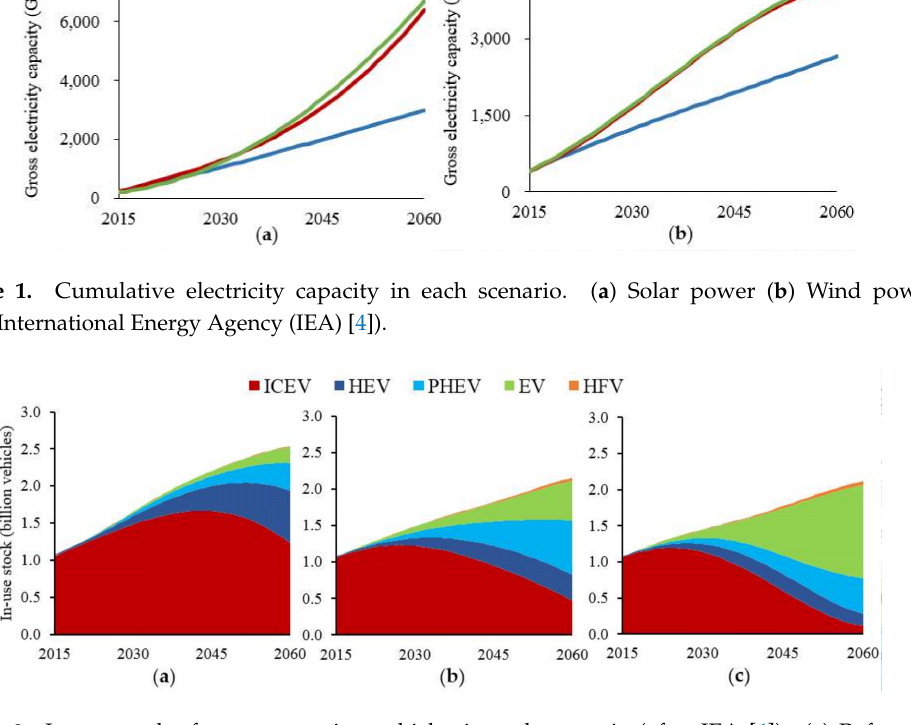
Figure 2. In-use stock of next-generation vehicles in each scenario (after IEA [4]). ( a ) Reference Technology Scenario (RTS) ( b ) 2 ◦ C Scenario (2DS) ( c ) Beyond 2 ◦ C Scenario (B2DS). (ICEV: internal